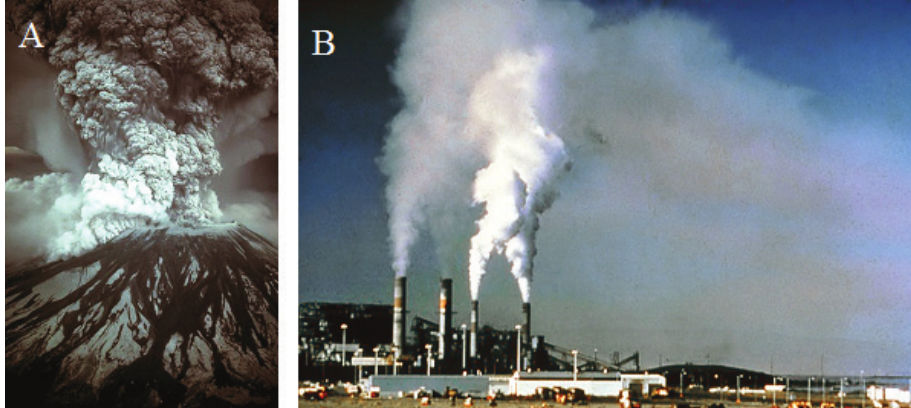
Figure 1. The process of climate change can be influenced by atmospheric composition change from natural sources such as volcanoes A or human-mediated sources such as electricity power stations B Clearly the two mechanisms of gas release have many significant differences, including the origins of the gases, nuanced sciences, rates, and policy implications, but their influence on the process of climate change is governed by identical laws of chemistry and thermodynamics. When considered holistically in the context of climate change, the two mechanisms are not THAT different, and are not two separate processes. A is courtesy of the U.S. Geological Survey, and B is courtesy of the U.S. National Parks